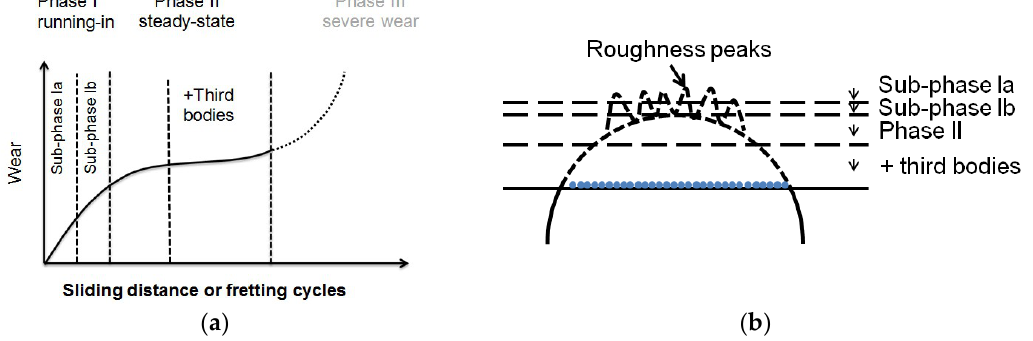
Figure 4. Wear process and the dominant factor in each phase, schematically: ( a ) Different phases in a wear process; ( b ) dominant factor causing thickness reduction in each phase: deformation of the roughness peaks in Sub-phase Ia; wear off of the roughness peaks in sub-phase Ib; contact surface is smoothed when the wear process moves to phase II, and the wear occurs on the spherical segment approximately for the spherical part; after long-term operation, the third bodies are aggregated in the contact area and influence the wear greatly.